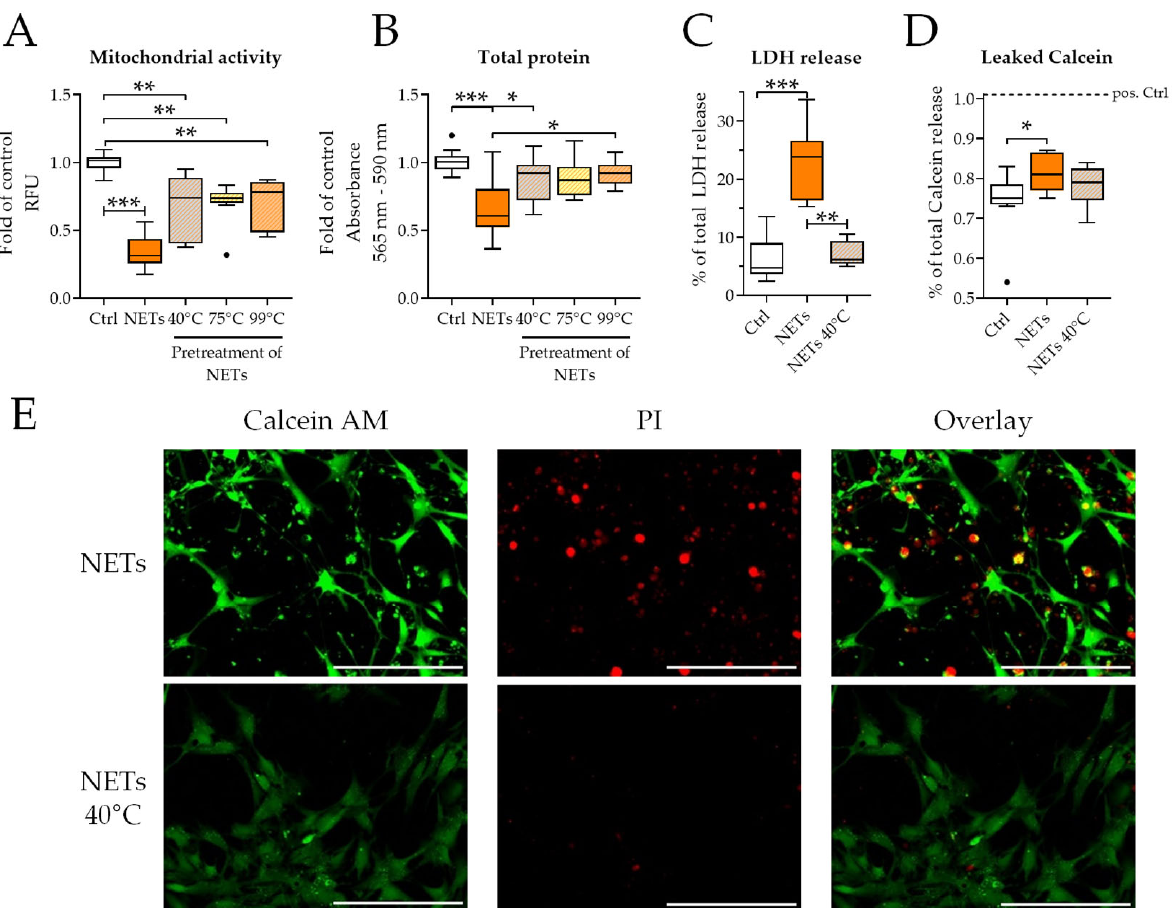
Figure 6. 40 °C is sufficient to block NETs toxicity. NETs were incubated at the indicated temperatures before addition to SCP-1 cells for 48 h. ( A ) Mitochondrial activity determined by Resazurin conversion measurement. ( B ) Total protein content determined by SRB staining. ( C ) Percental LDH release as a marker for cell death. ( D ) Release of Calcein into the SCP-1 cell culture supernatant after 22 h of incubation, pos. Ctrl is Triton-X-100-treated cells. ( E ) Calcein-AM/PI staining of SCP-1 cells after 22 h. Scale bar 200 µ m. N = 3, n = 3. * p < 0.05, ** p < 0.01, *** p < 0.001, as determined by the Kruskal–Wallis